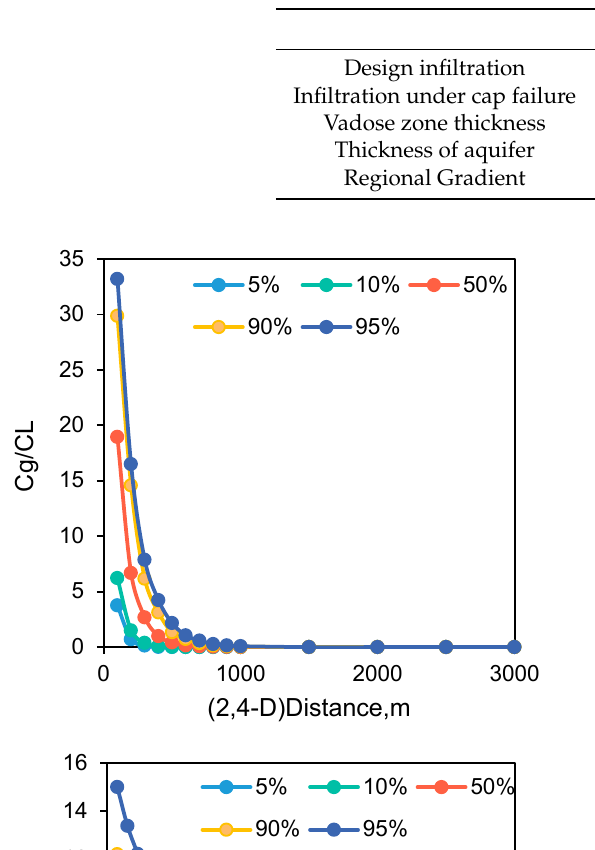
Table 3. Uncertain parameters and their values in the model.